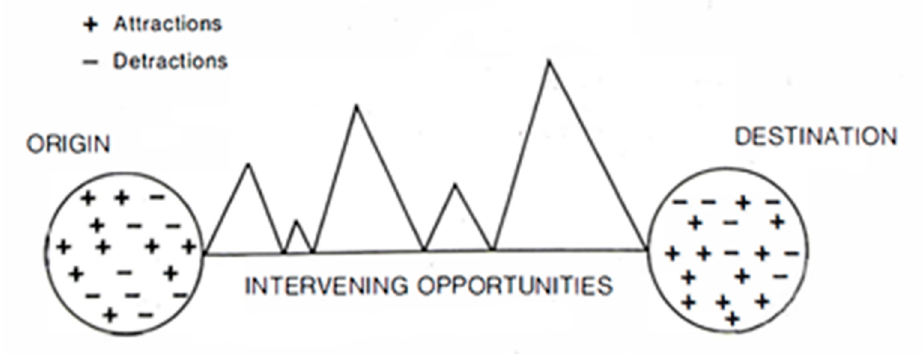
Figure 1. An illustration of Everett Lee’s model of population mobility [29].